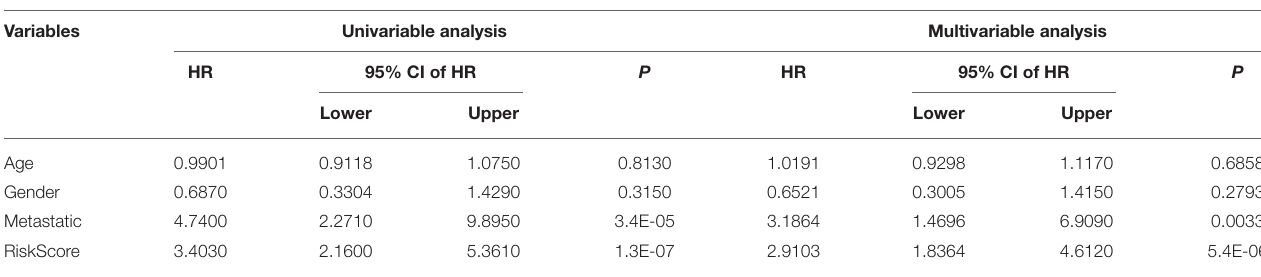
TABLE 2 | Univariable analysis and multivariable analysis of the entire